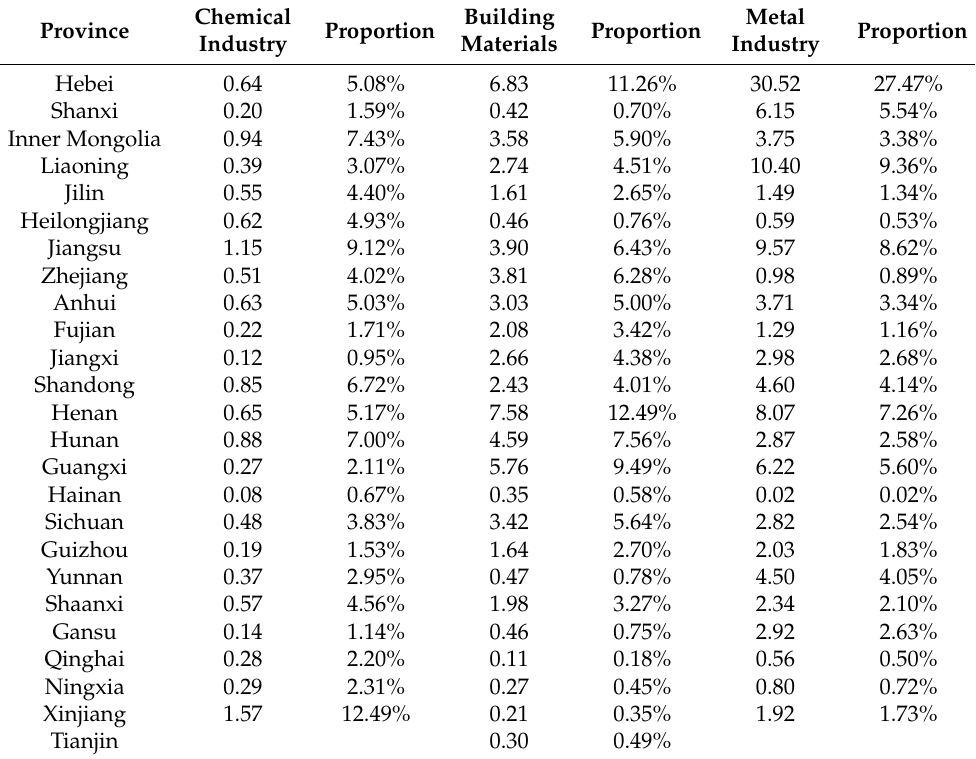
Table 6. Transfer in and proportion of carbon emissions in non-pilot areas (unit: MtCO 2 ). Chemical Province Proportion Industry